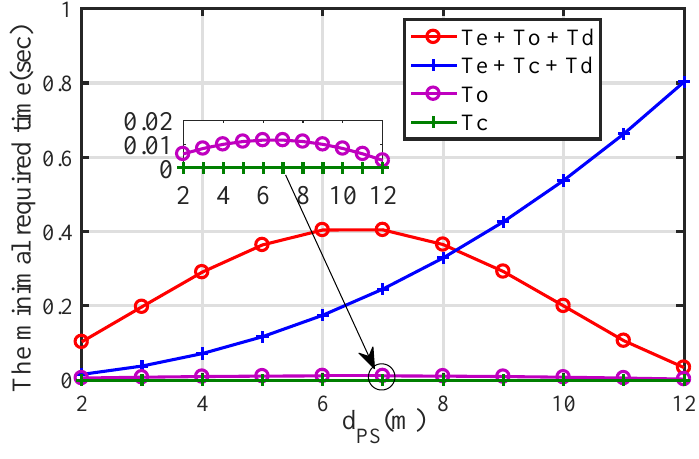
Figure 5. The minimal required time versus d ps